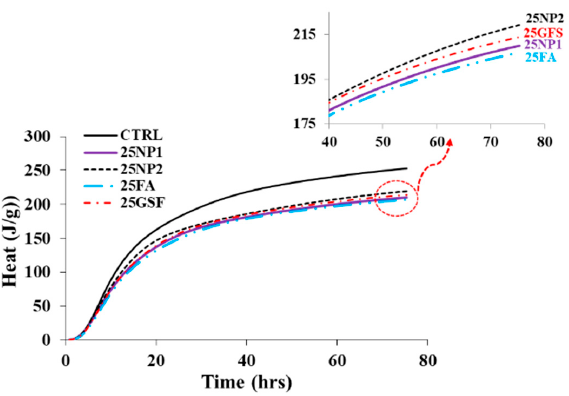
Figure 19. Isothermal analyses of concrete mixes showing total heat of hydration until 80 h.